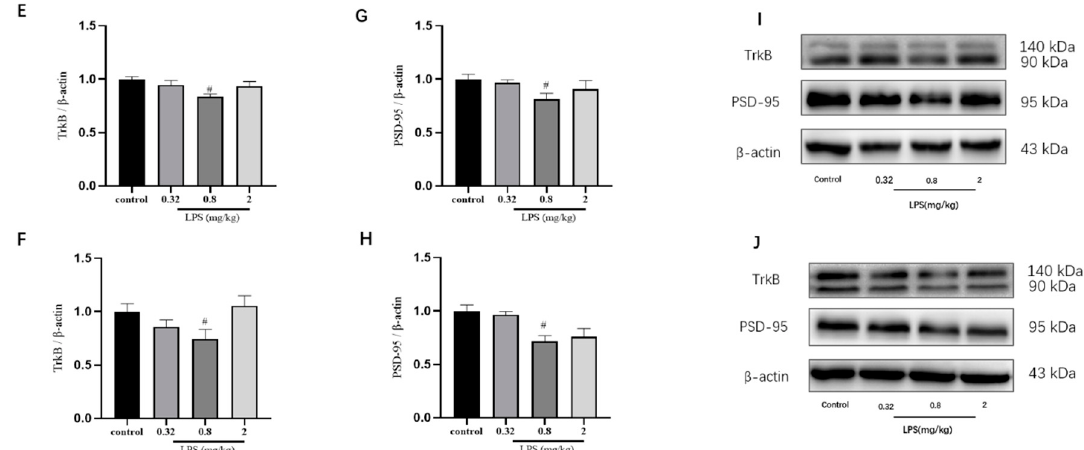
Figure 2. Effects of different doses of lipopolysaccharide (LPS) (i.p.) on brain neuroplasticity of mice. Representative micrographs of Nissl staining in the hippocampus ( A ) and prefrontal cortex ( B ). The scale bar represents 200 μ m in the image. Quantification of integrated optical density (IOD) of Nissl bodies in the hippocampus ( C ) and prefrontal cortex ( D ) ( n = 3 for each group). Representative western blot analysis of TrkB and PSD-95 in the hippocampus ( E , G ) and cortex ( F , H ) ( n = 4 for each group). Representative protein bands for the hippocampus ( I ) and cortex ( J ). Graphs are plotted as mean ± SEM. Data were analyzed by the Mann–Whitney U test. # p < 0.05 compared to the control group.